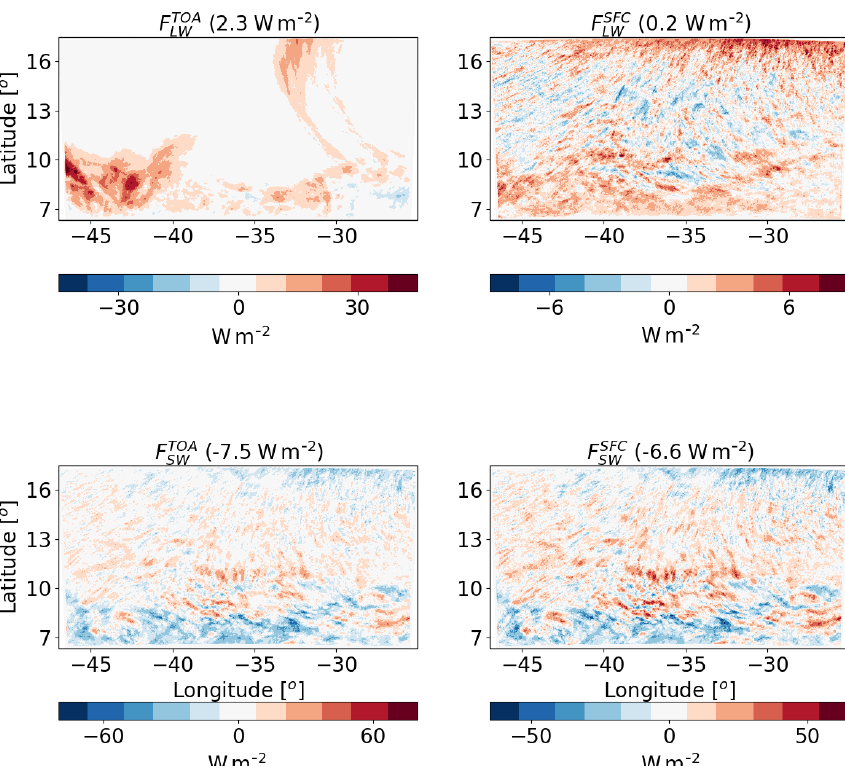
Figure 7. The differences between polluted (CDNC = 200cm − 3 ) and clean (CDNC = 20cm − 3 ) ICON simulations of the time-mean ra- diative longwave (LW) and shortwave (SW) fluxes at the top of atmosphere (TOA) and surface (SFC) for the shallow-cloud-dominated case (10–12 August 2016). The domain- and time-mean value of each term appear in